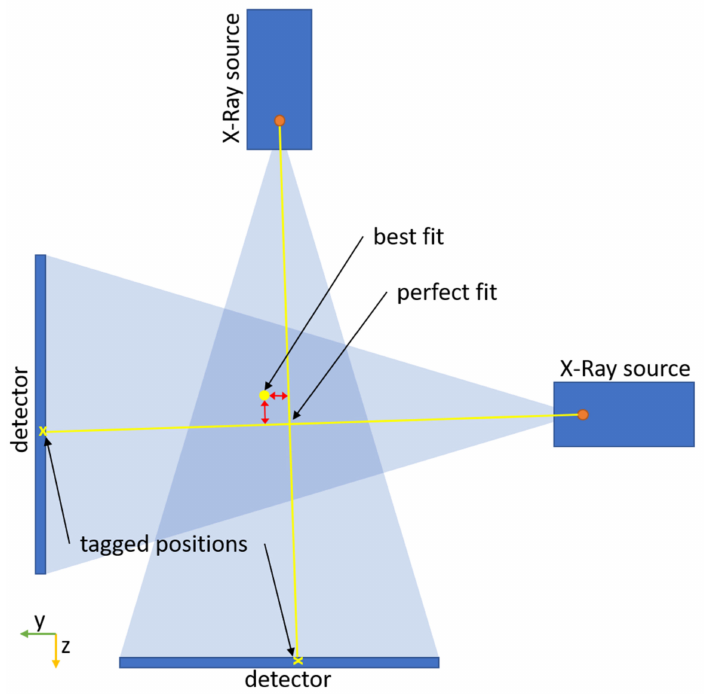
Figure 6. Schematic representation of the deviation for the error estimation in 2D (yz-plane). The deviation is shown as red arrows. The “perfect fit” is the intersection of the line between focal spot of the X-ray source and the tagged position on the X-ray image.